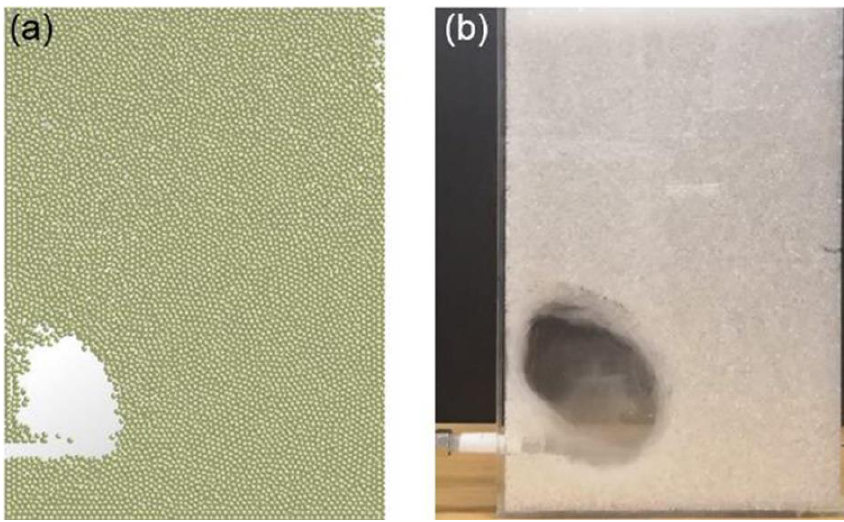
Figure 3. Void formation obtained in simulation ( a ) and experiment ( b ) under the same conditions.